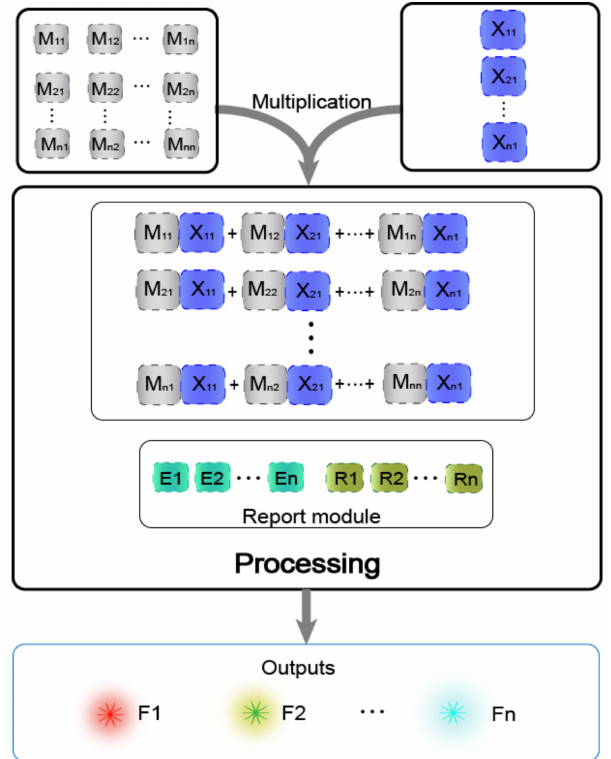
Figure 3. Schematic diagram of N × N matrix multiplication based on the mechanism of the DNAzyme binding to double auxiliary strands to cleave the